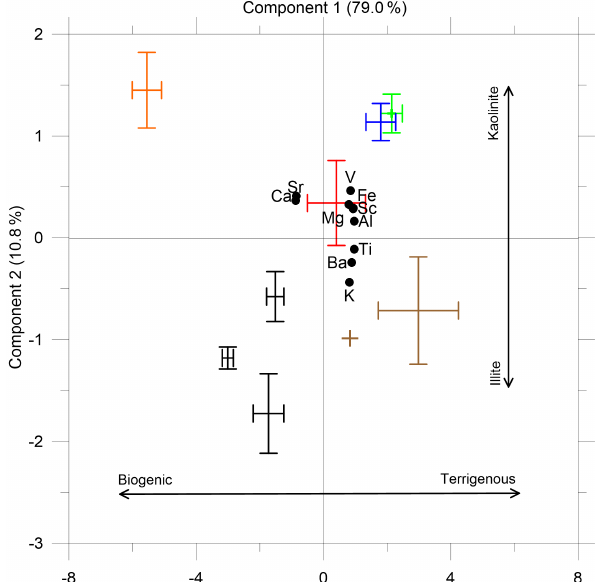
Figure 3. Biplot (samples and variables) of average ± standard de- viation of the first and second components of the principal compo- nent analysis of metals. Colours refer to samples from coast and inner shelf (brown), outer shelf and upper slope (black), relict outer shelf sediment (orange), upper slope – SACW (green), middle slope – IWBC (red) and middle slope – DWBC